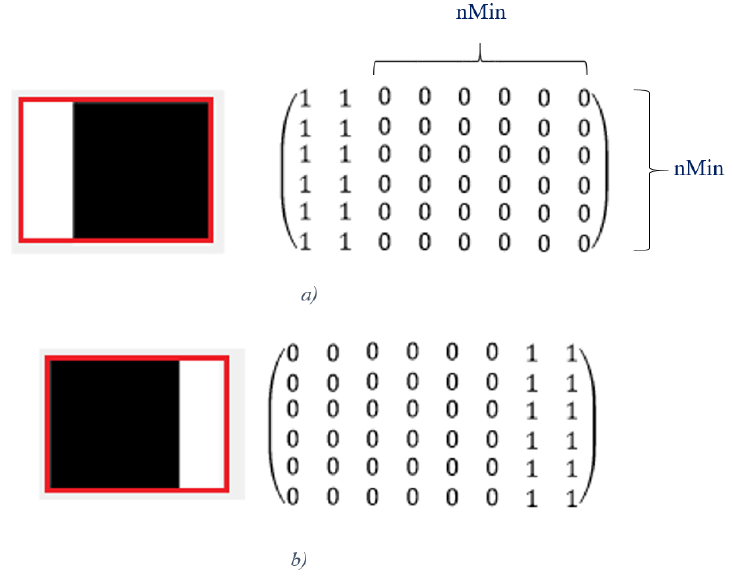
Figure 5 . ( a ) Left side pattern; ( b ) right side pattern. Figure 5. ( a ) Left side pattern; ( b ) right side